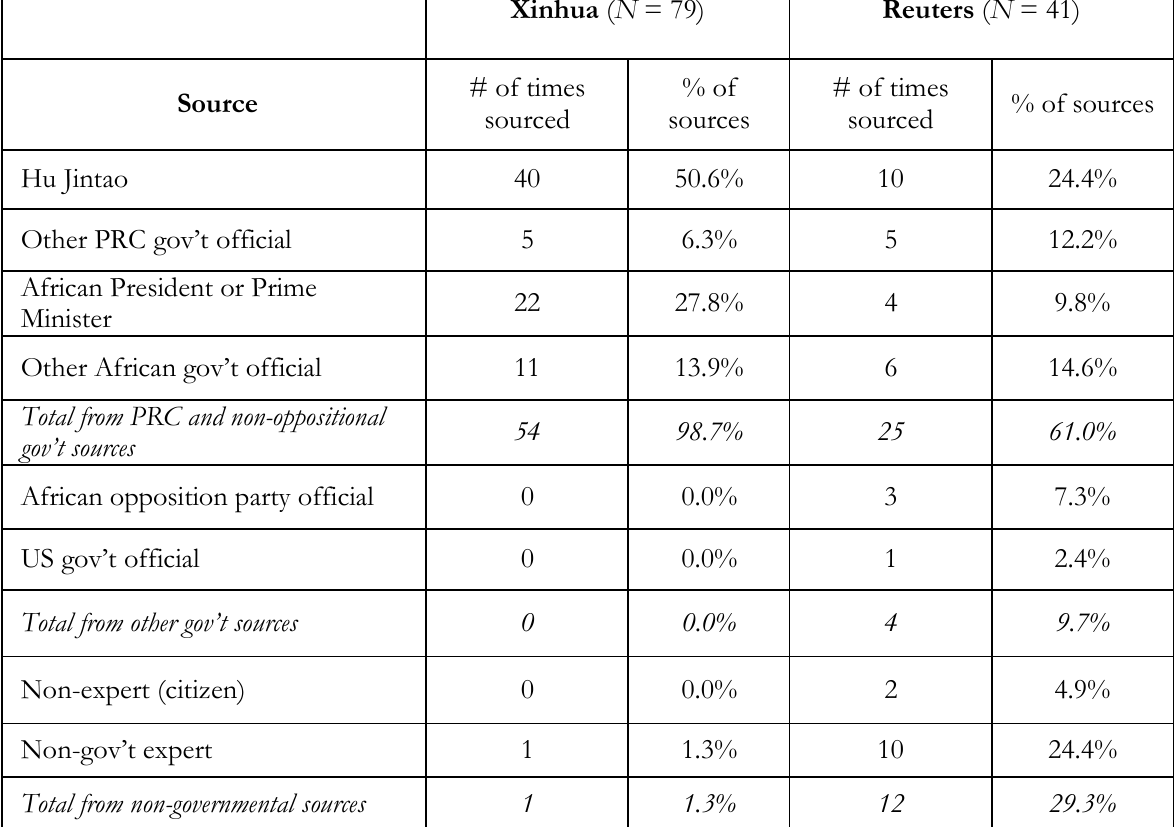
Table 1: Origin and number of sources, Xinhua and Reuters, 31 Jan. to 8 Feb.